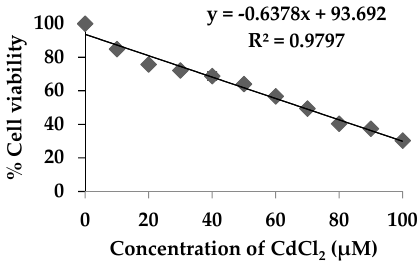
Figure 2. Effect of different concentrations of CdCl 2 on the cell viability of HEK293 kidney cells. Data are means ± standard deviation (SD).